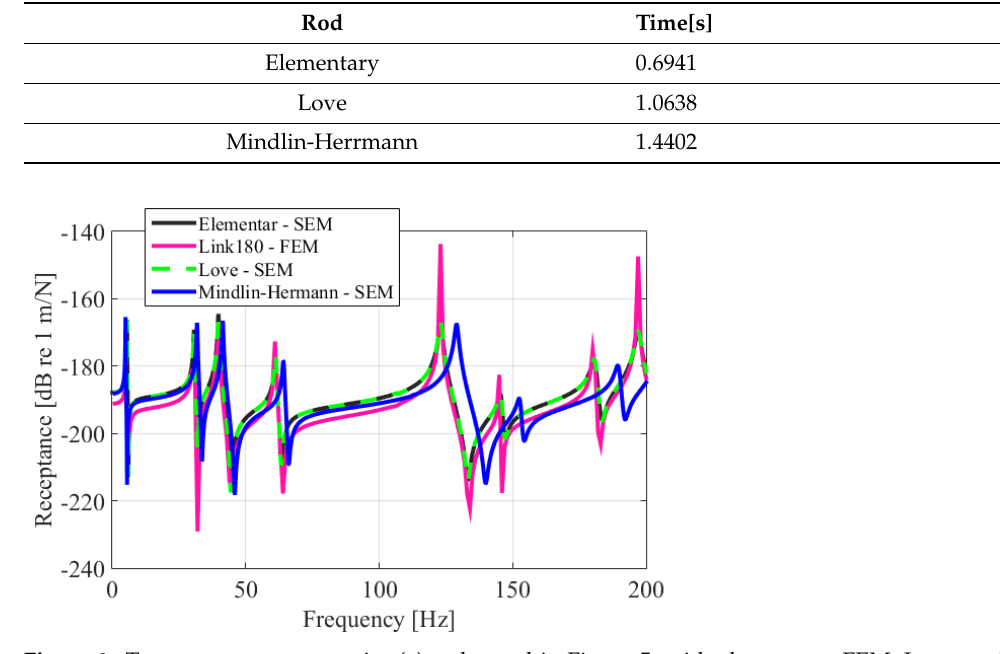
Figure 8. Tower receptance at point (a) as located in Figure 5, with elementary, FEM, Love, and Mindlin-Herrmann models